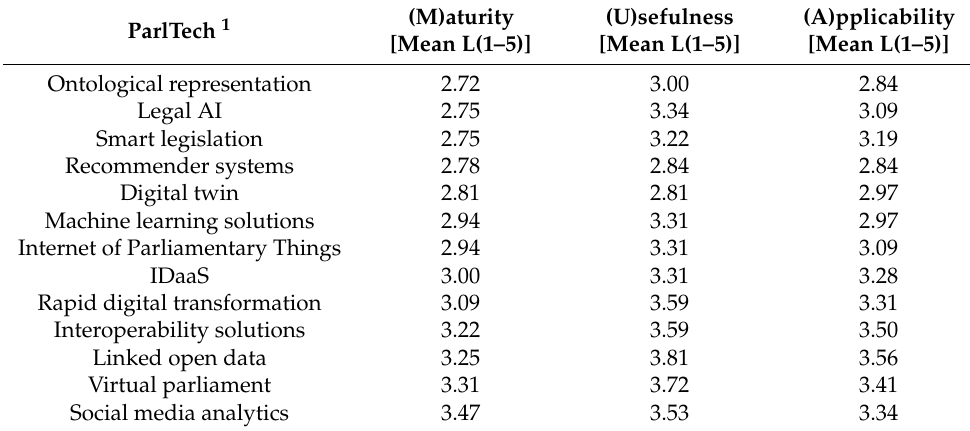
Table 2. Maturity, usefulness, and applicability of